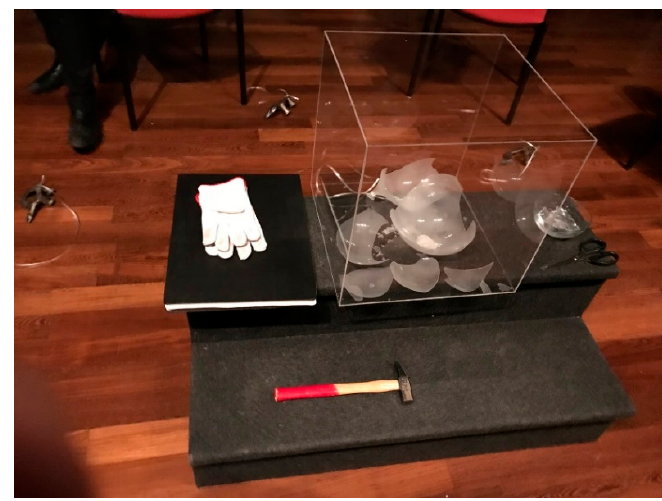
Figure 4. Broken glass balloon after a performance of Phobophobia . 1